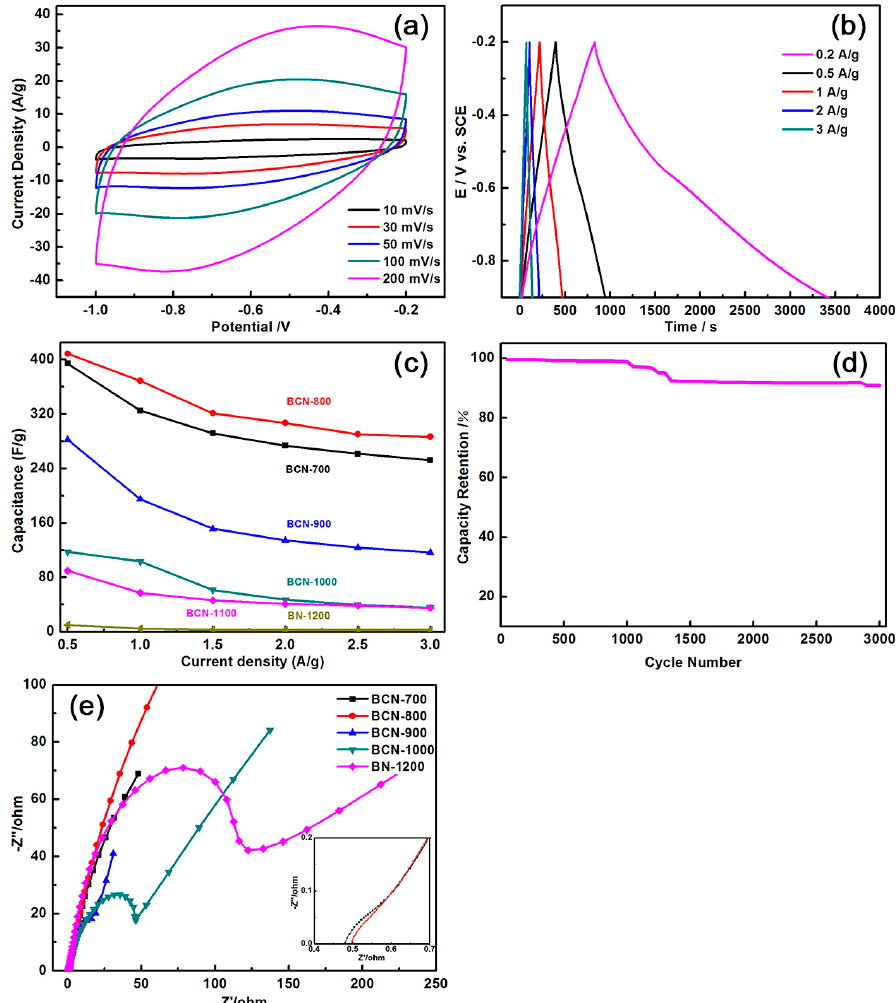
Figure 6. ( a ) Cyclic voltammetry (CV) curves of BCN-800 at various scan rates in 6.0 M KOH electrolyte solution; ( b ) Galvanostatic charge/discharge curves of BCN-800 at a current density of 0.2 A/g in 6.0 M KOH electrolyte solution; ( c ) The specific capacitance at the current density from 0.5 to 3 A/g; ( d ) the stability evaluation of BCN-800 electrode material in 6 M KOH solution at a charge current of 8 A/g; ( e ) Nyquist plots of samples in 6 M KOH solution. The inset shows the enlarged Nyquist plots in the high-frequency area of BCN-700 and BCN-800.